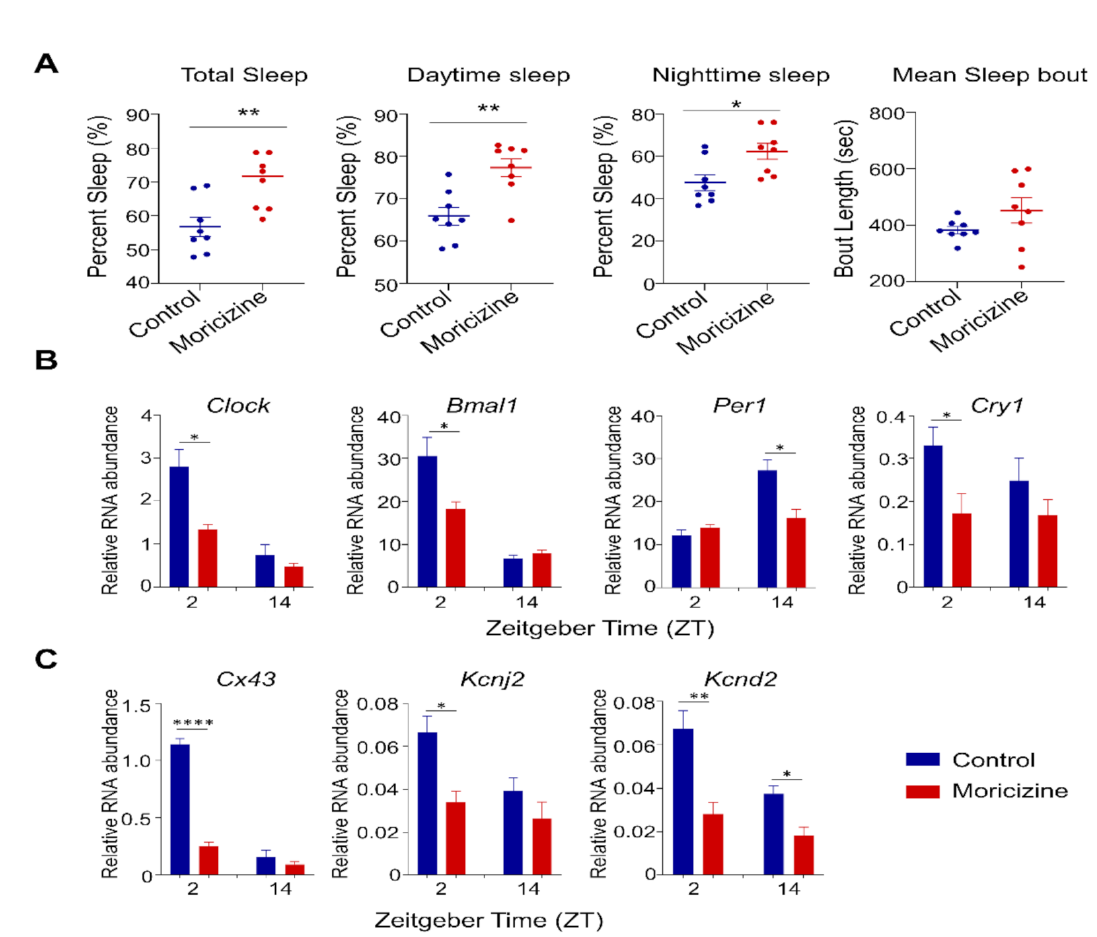
Figure 5. Moricizine effects on sleep and heart gene expression in C57BL6/J mice. ( A ) Total percent sleep time, daytime sleep time, nighttime sleep time, and mean sleep bout length of wild-type C57BL/6J mice with vehicle (PBS, blue, n = 8) or moricizine (1.25 mg per mouse, red, n = 8). Real-time qPCR analysis of clock genes (( B ); Clock, Bmal1, Per1, and Cry1 ) and cardiac channel (( C ); Cx43, Kcnj2 , and Kcnd2 ) in heart tissues of control (blue bar, n = 4 for ZT 2 and ZT14) and moricizine treated mice (red bar, n = 4 for ZT2 and ZT14). Data are presented as mean ± SEM. T -test shows significant statistical differences between control and moricizine treated groups. (*, p < 0.05; **, p < 0.01; ****, p <